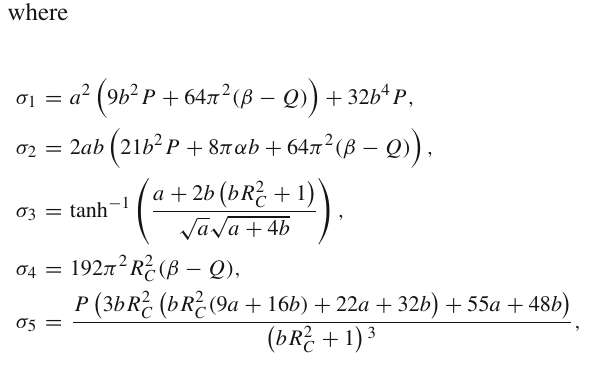
Fig. 4 Variation of pressures and density ratios with radial coordinate r for (i) the neutron star in Vela X-1(upper) (ii) SMC X-4 (middle) (iii) Her X-1